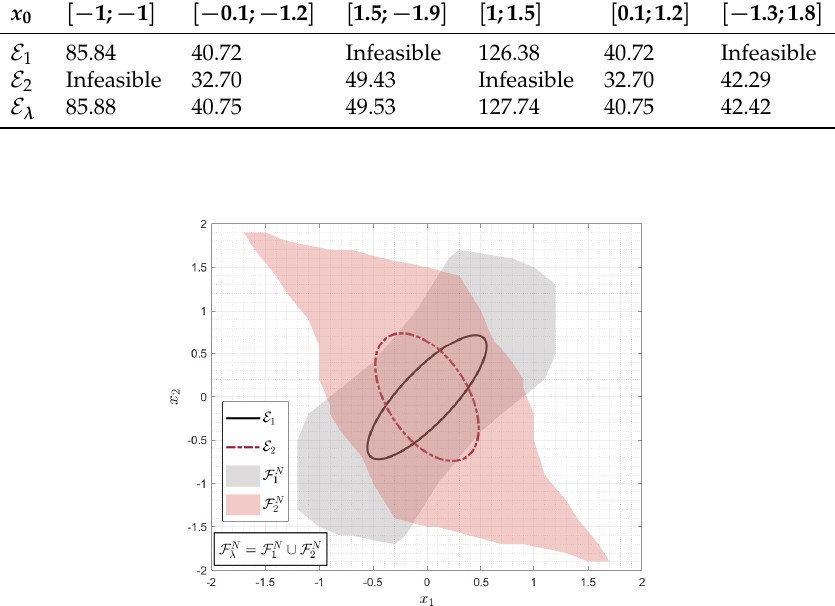
with N = 2. i = F N ∪ F N 2 1 λ